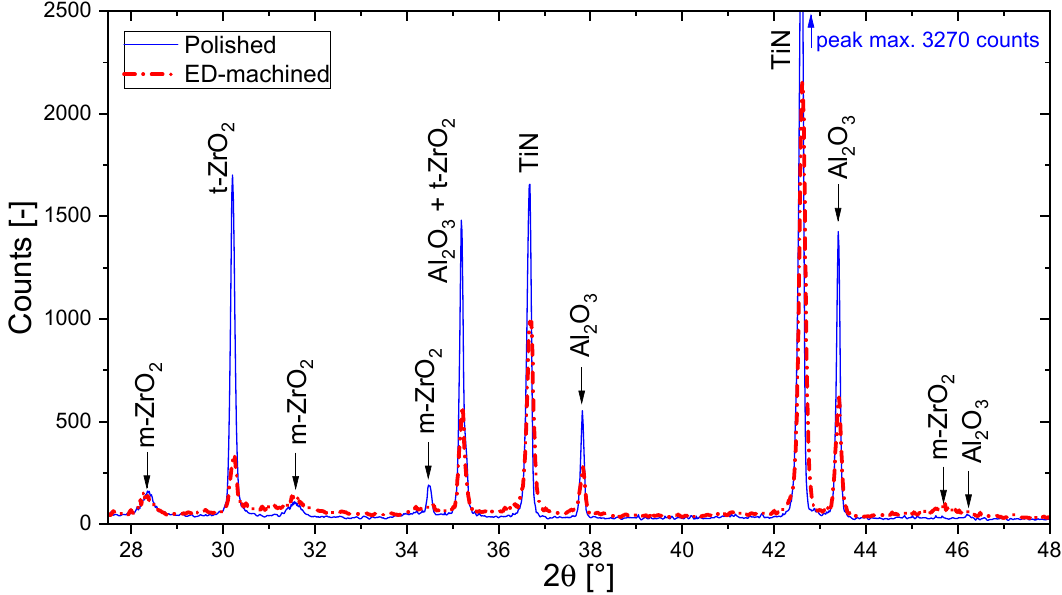
Figure 9. X-ray di ff ractogram of polished and ED-machined